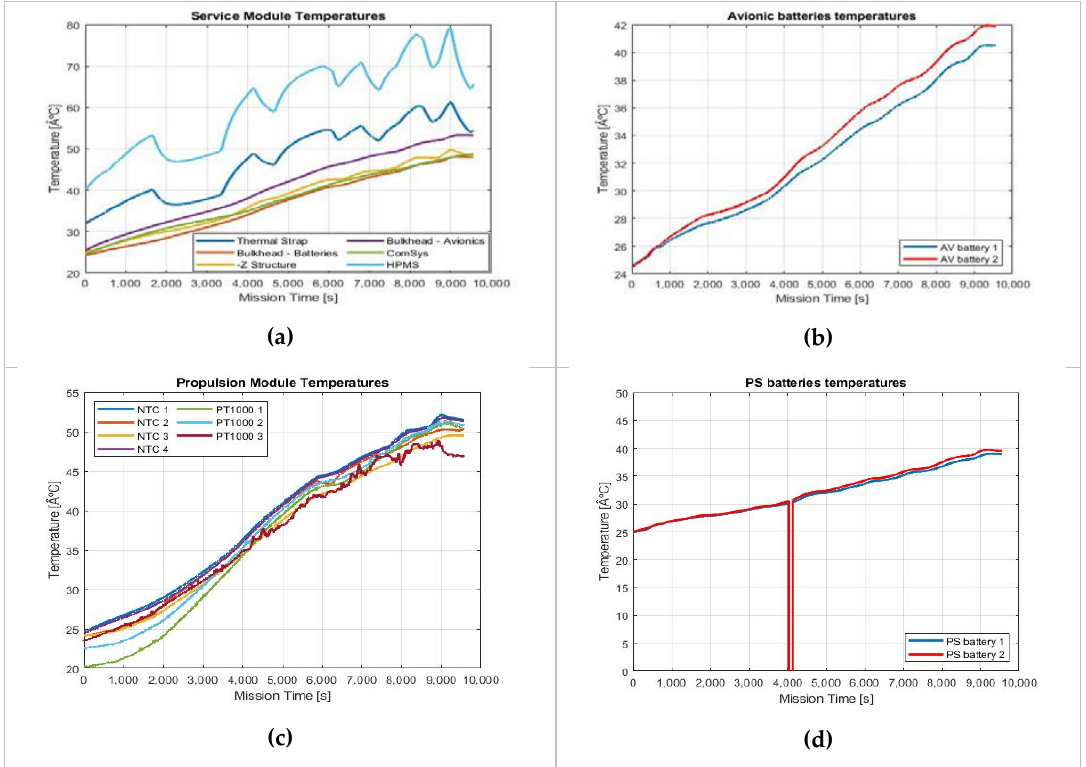
Figure 11. Onboard temperatures: ( a ) temperatures in service module, ( b ) temperatures of the Avionics Battery packs, ( c ) temperatures in PS module, ( d ) temperatures of PS battery packs.